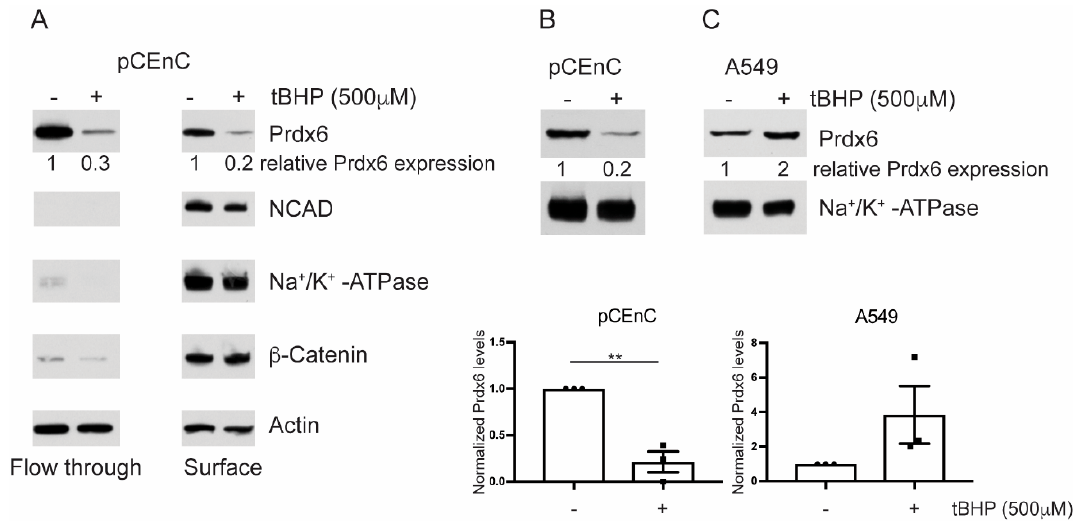
Figure 2. Prdx6 levels are sensitive to oxidative stress. ( A ) Primary cultures of human CEnCs) were treated with tert-butyl hydroperoxide (tBHP) for 3 h. pCEnCs were biotinylated and cell surface proteins purified by immunoprecipitation. The flow-through, unbound fraction served as a control for membrane fractionation. ( B ) pCEnCs and ( C ) A549 cells were treated with tBHP for 3 h and plasma membrane was isolated by density dependent centrifugation. Data from three independent experiments ± SEM is shown. Prdx6 levels were normalized to Na + /K + -ATPase and expressed relative to untreated ( − ) controls. Student t -test was performed to evaluate statistical significance (** p -value < 0.005).